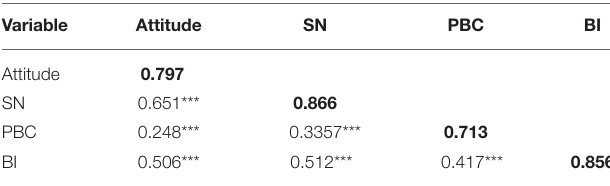
TABLE 3 | Discriminant validity test ( n =